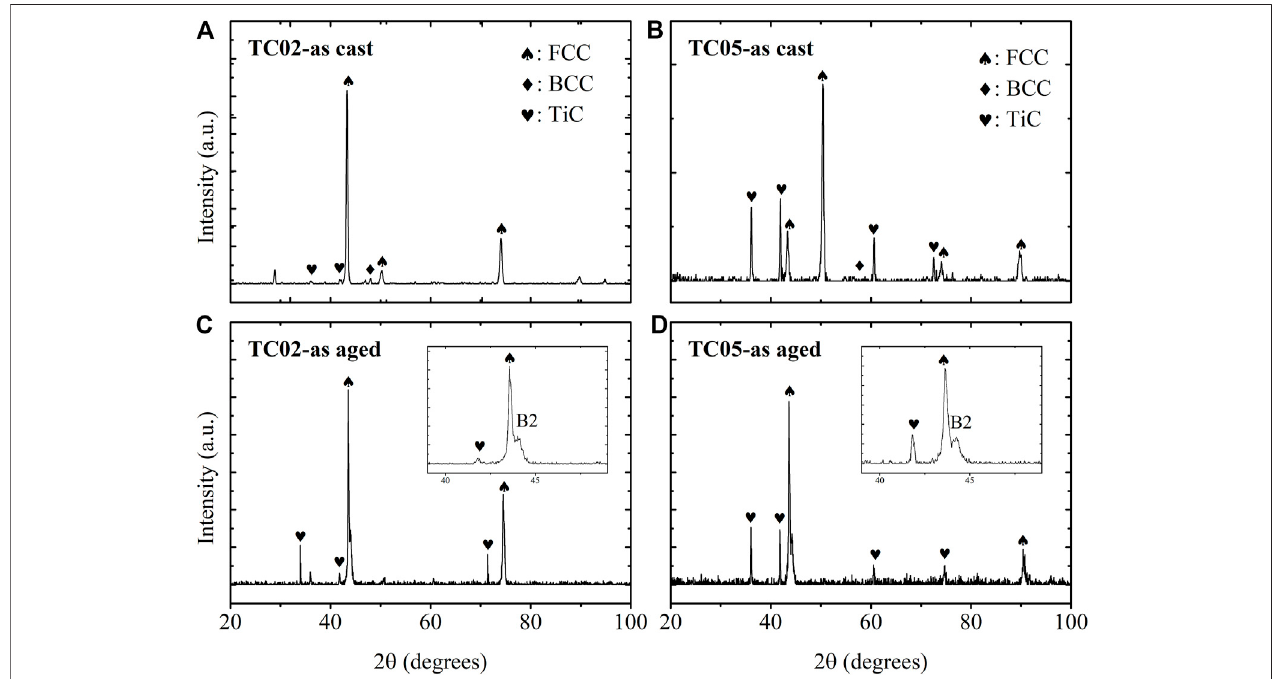
FIGURE 2 | XRD of (A) as-cast TC02, (B) as-cast TC05, (C) as-aged TC02, and (D) as-aged TC05 alloys.